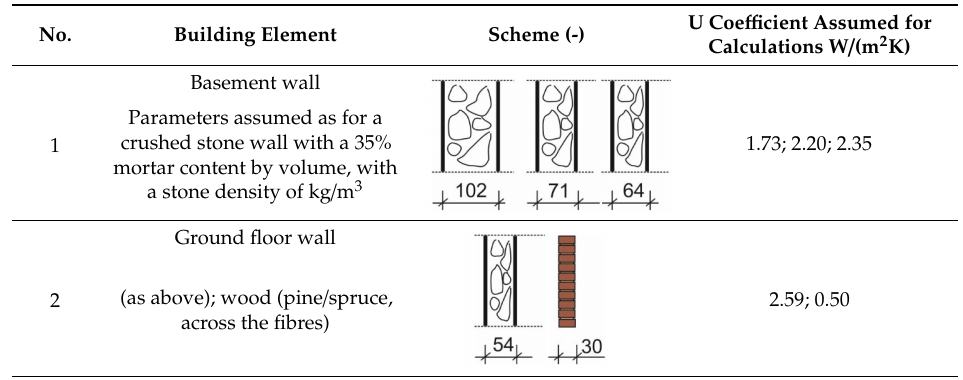
Table 1. Thermal transmittance of the external walls of the Stara Polana building, as assumed for calculations.